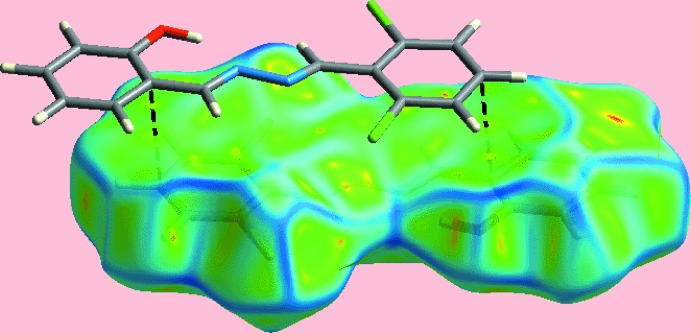
A view of Hirshfeld surface mapped with curvedness showing edge-to-edge π–π overlap through black dashed lines.